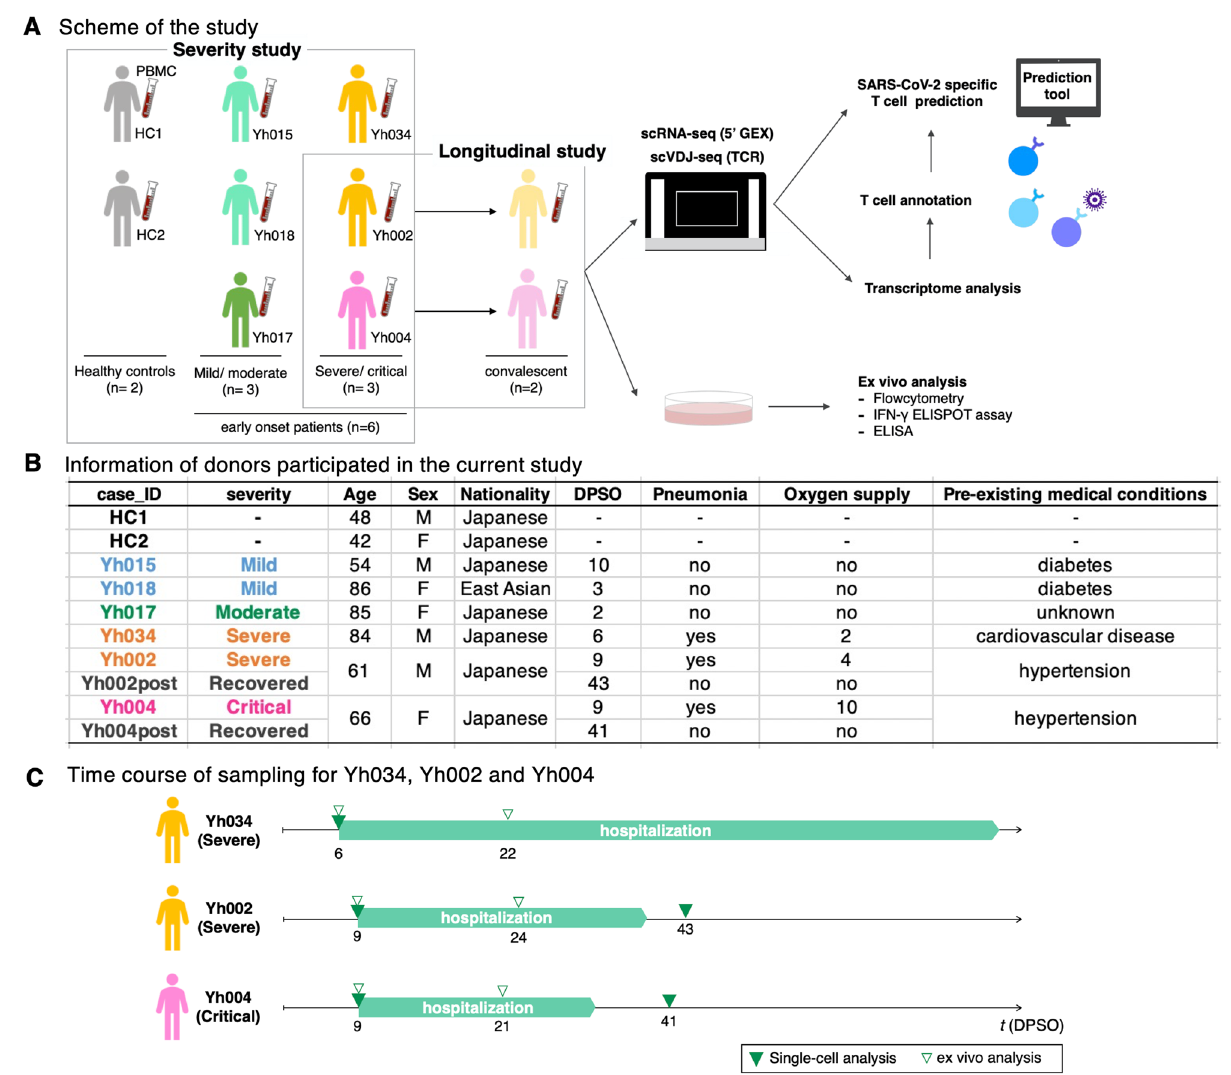
Figure 1. Strategy of the current study. (A) PBMCs are separated from whole blood samples and analyzed by 10 × Genomics Chromium scRNA-seq and scVDJ-seq (TCR). Our datasets include two healthy donors and six COVID-19 patients: two mild, a moderate, two severe, and a critical patient. Those patients are divided into two groups: mild/moderate (Yh015, Yh018, and Yh017) and severe/critical (Yh034, Yh002, and Yh004). (B) Inset table shows donors’ basic and clinical information. DPSO shows the timepoint of days post symptom onset at single-cell analysis. (C) Time course of sampling for Yh002, Yh004, and Yh034. The period of hospitalization and timepoint of analysis are shown. Legend is shown in the